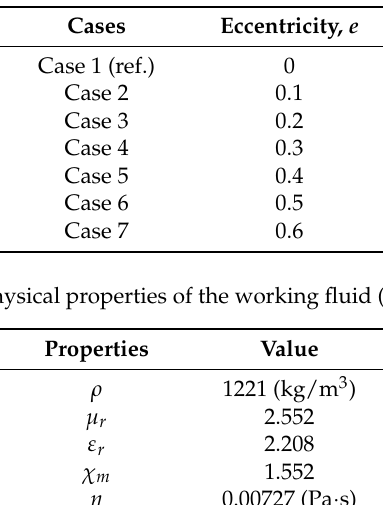
Table 1. Eccentricity of the inner cylinder.